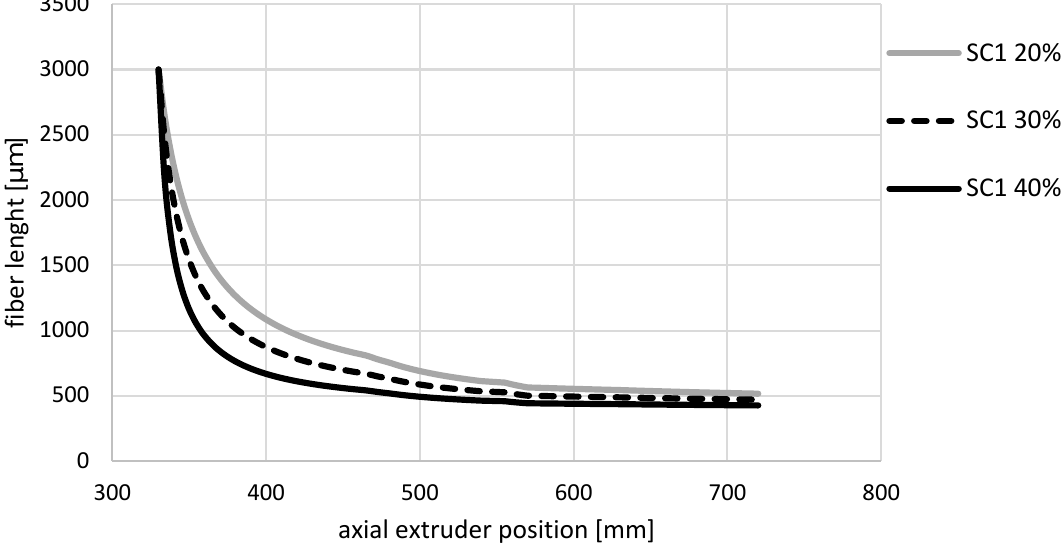
Figure 7. Simulated fiber length curves for the glass fiber content 20, 30, and 40 wt.% for the screw configuration SC1 along the axial extruder position.